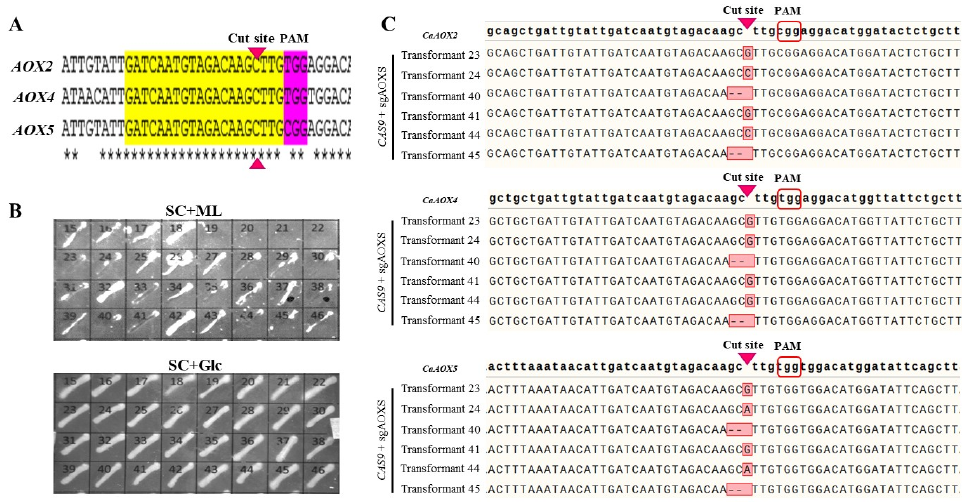
Figure 3. Multiple gene disruption by single gRNA. ( A ) Sequence alignment of CaAOX2 , CaAOX4 and CaAOX5 genes. The conserved gRNA target sequence (20 bp) and PAM sequence were indicated. ( B ) Growth of mutants on methyl laurate (SC + ML) and glucose (SC + Glc) as a sole carbon source. ( C ) Sequence analysis of six different mutants. Insertions or deletions were indicated (red box).